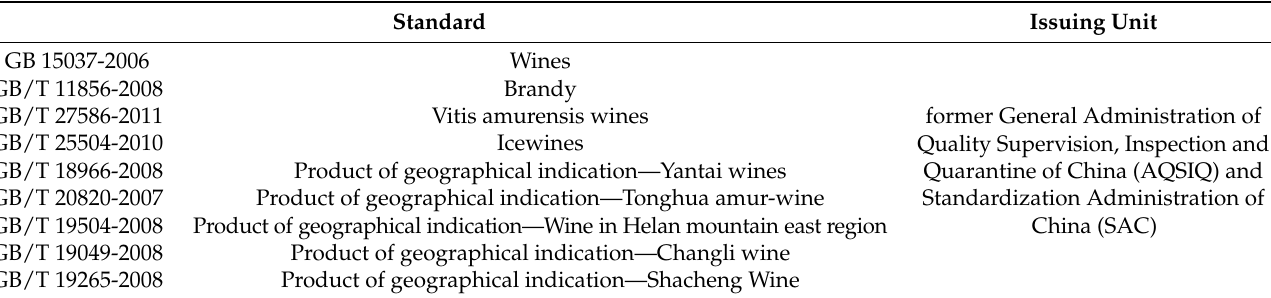
Table 1. National wine product standards in